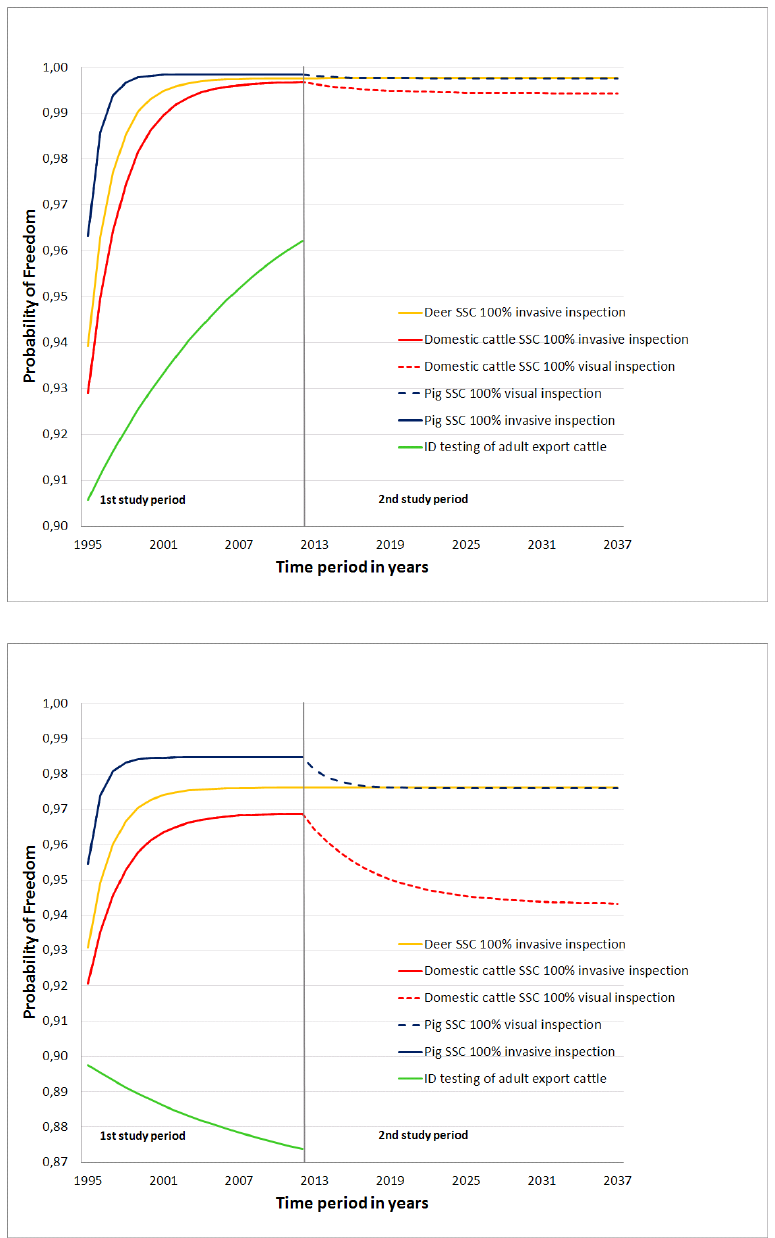
changes were observed in the results. Nor did it change the results much if the submission of detected lesions for bacteriological culture was set to 100% instead of 10%, as in the current scenario. Figure 1. Temporal discounting, estimating the probability of freedom from bovine tuberculosis in Denmark, for the first study period (1995–2012) under the current surveillance system for the four surveillance system components and for the second study period (2013–2037) under the alternative surveillance programmes: Scenario 1 where all the domestic cattle would be subjected to visual meat inspection and Scenario 2 where all pigs would be subjected to visual meat inspection. Export cattle were tested using intradermal tuberculin test (ID). The top graph shows the results from the scenario with 0.1% and the bottom graph the scenario with 1% probability of